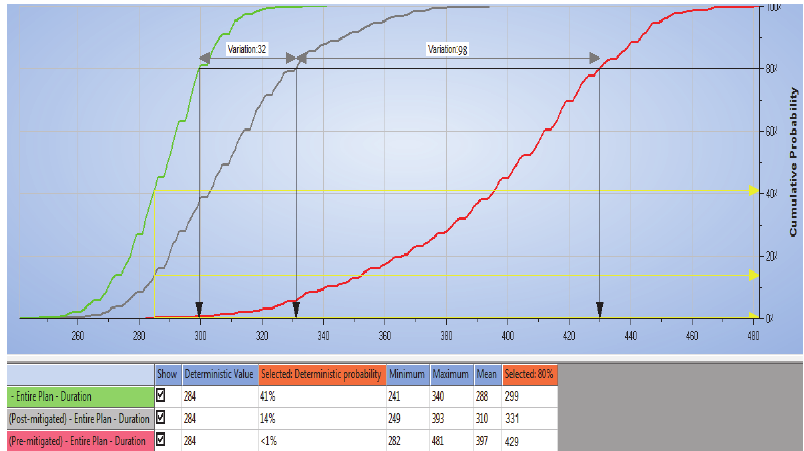
Fig. 6. Simulation of project duration for three